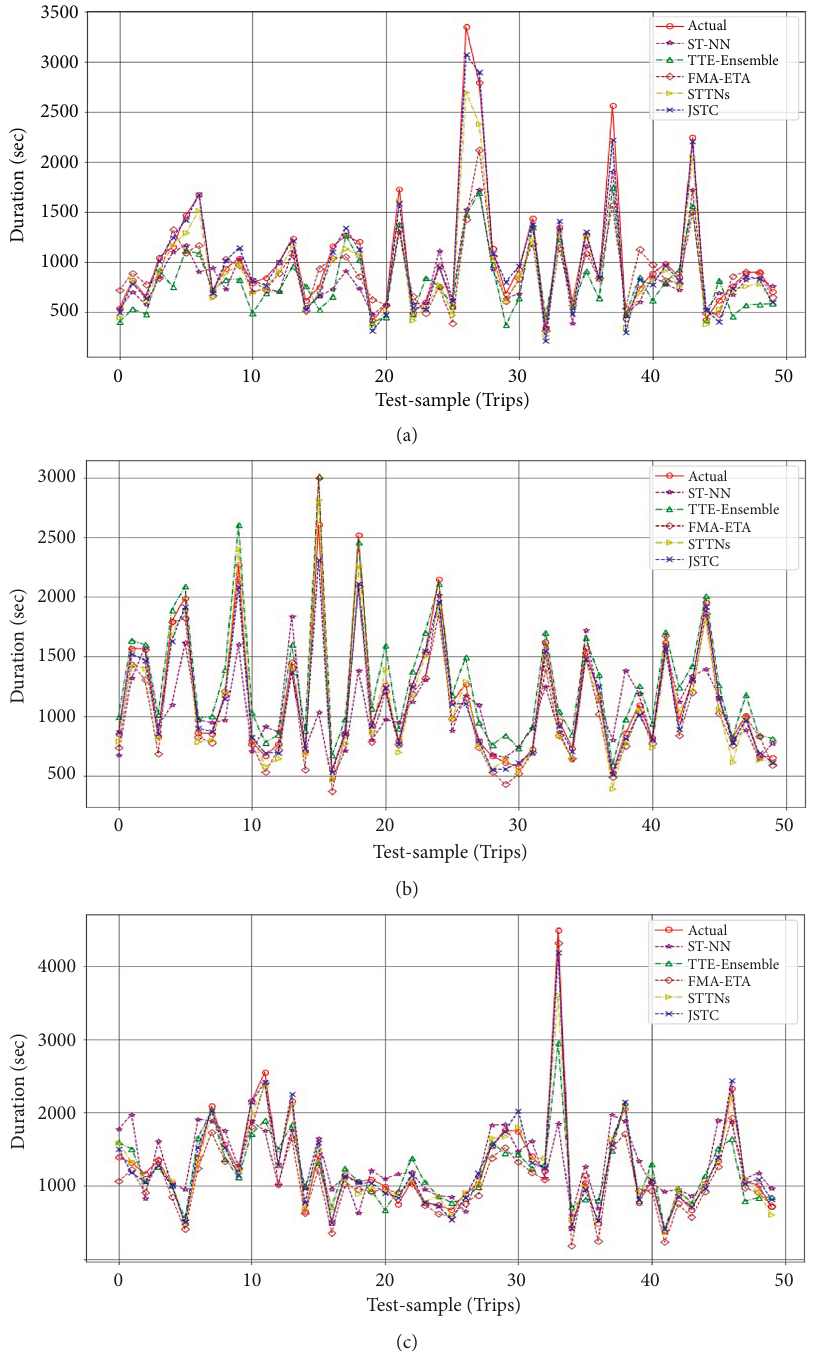
Figure 7: Comparison of prediction vs. actual values for all models on (a) NYC, (b) Chengdu, and (c)